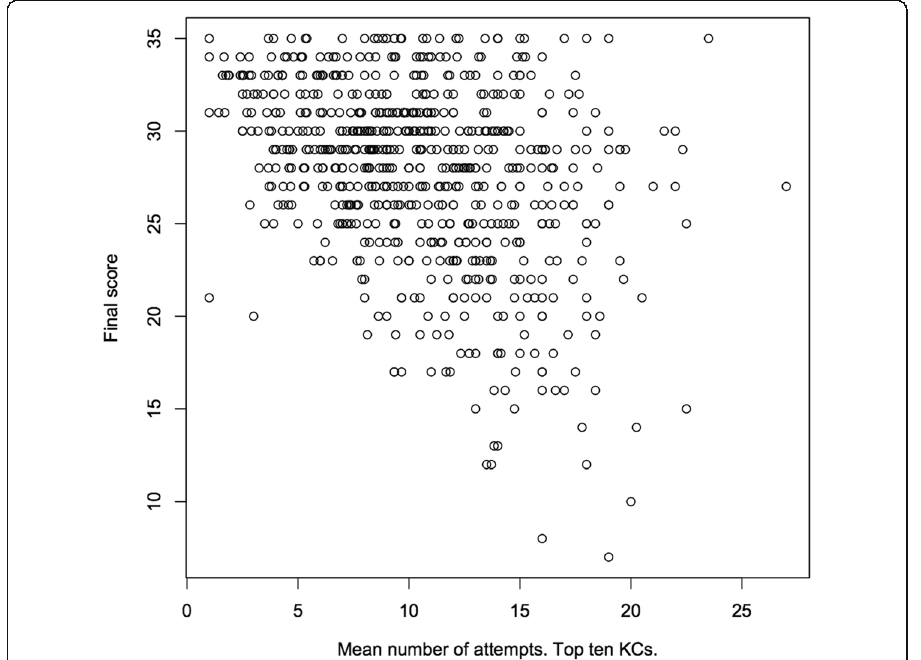
Fig. 3 Scatterplot over the mean for the top ten KCs and final test score